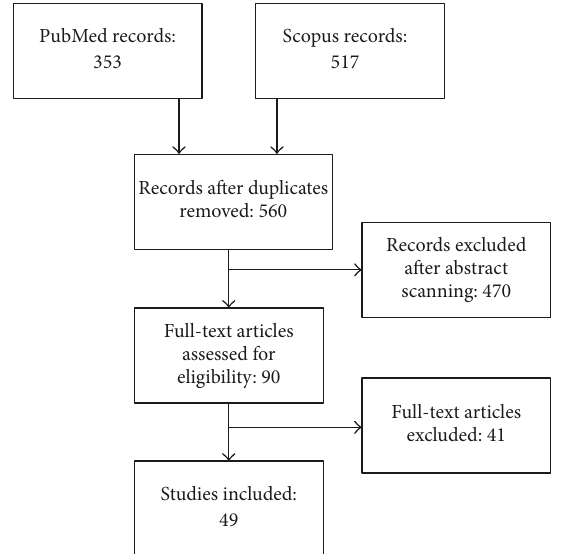
Figure 1: PRISMA flow chart diagram for study